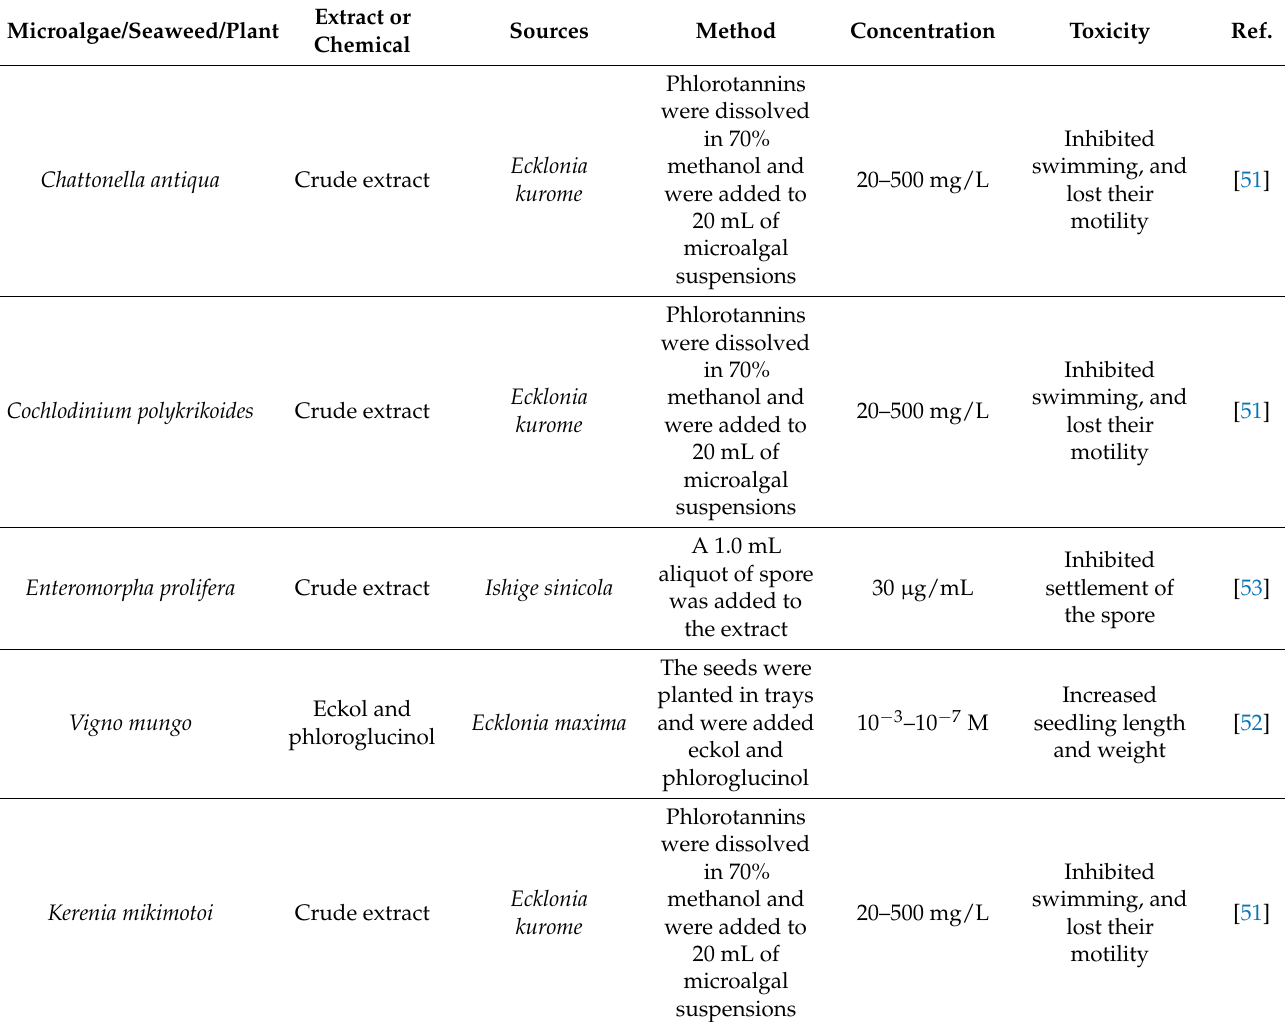
Table 3. Studies of safety and toxicity of phlorotannins extracted from brown seaweeds, as measured in microalgae, seaweed, and